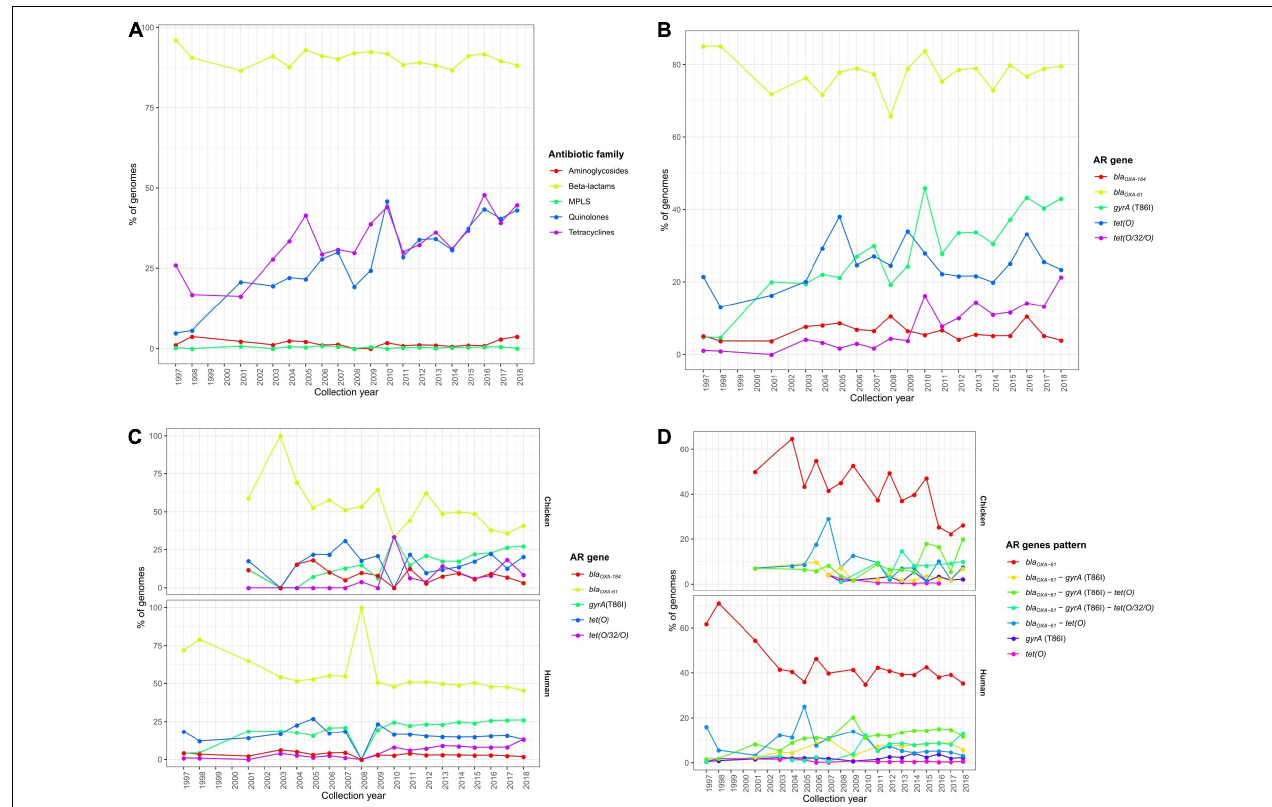
FIGURE 7 | Temporal changes in the resistome of European C. jejuni genomes. Prevalence of (A) ARGs or SNPs associated with resistance to different antibiotic families and (B) the main ARGs or SNPs found on all European C. jejuni genomes and (C) main ARGs or SNPs and (D) AR patterns on C. jejuni genomes from chicken and human sources along the last 20